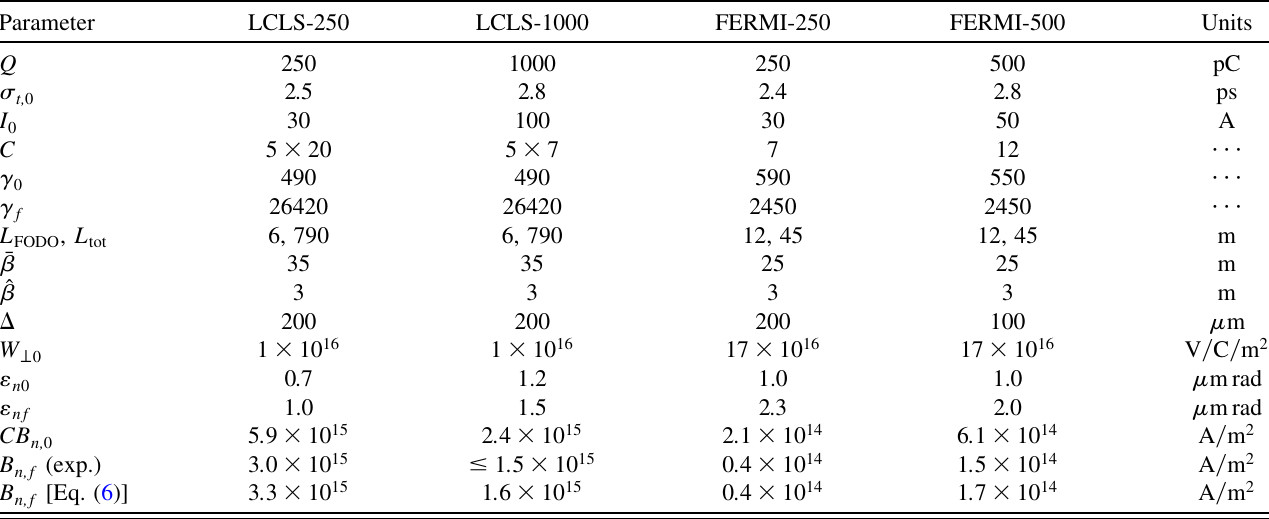
TABLE I. LCLS and FERMI electron beam and machine parameters. The peak current I 0 is defined as Qc divided by 3 : 5 (cid:4) z; 0 , where Q is the beam charge, c is the light speed in vacuum, and (cid:4) z; 0 is the rms bunch length. The normalized emittance is the geometric mean of the horizontal and the vertical